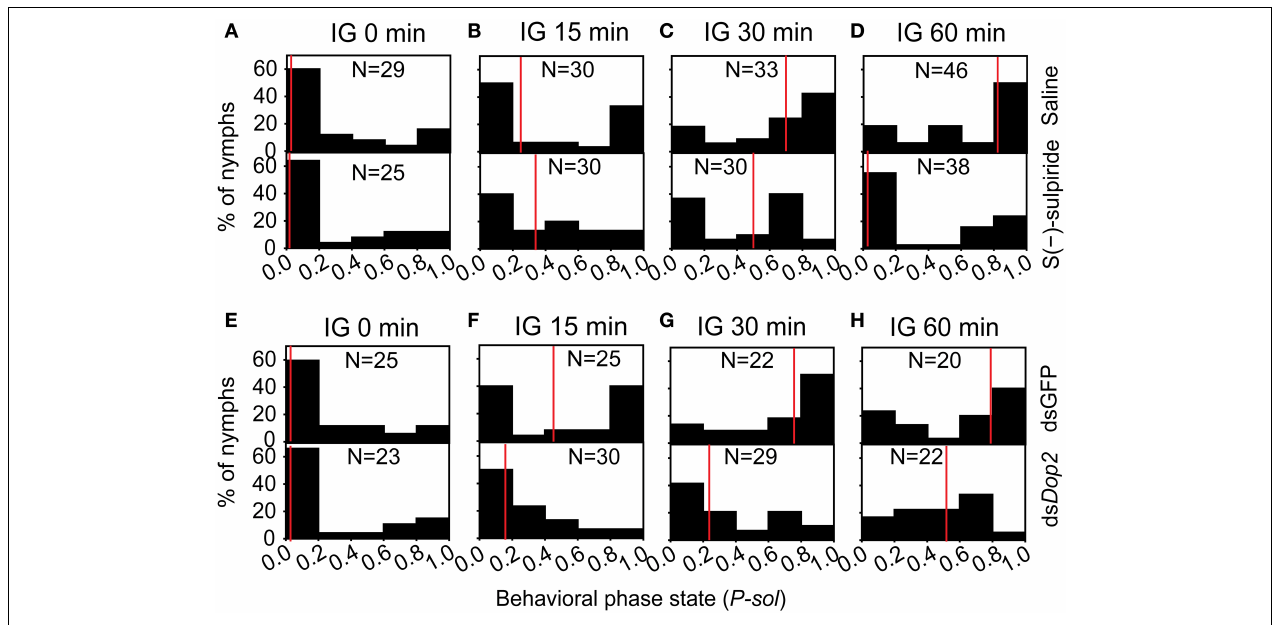
FIGURE 6 | Behavioral change in isolated gregarious locusts with deficiency of Locusta Dop2 signaling. (A) Behavioral state of gregarious locusts after injection of Dop2 antagonist S(-)-sulpiride. (B–D) Behavioral state of gregarious locusts with 15min (B) , 30min (C) , and 60min (D) of isolation after injection of S(-)-sulpiride. (E) Behavioral state of gregarious locusts after RNAi knockdown of Locusta Dop2. (F–H) Behavioral state of